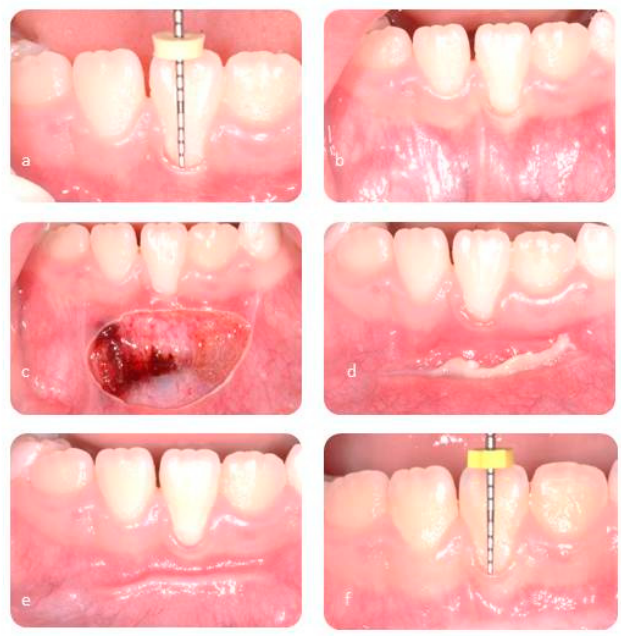
Figure 2. CO 2 laser: pre-operative evaluation ( a , b ), surgical wound ( c ), follow-up after seven days ( d ), follow-up afeter thirty days ( e ), follow-up after six months ( f ).